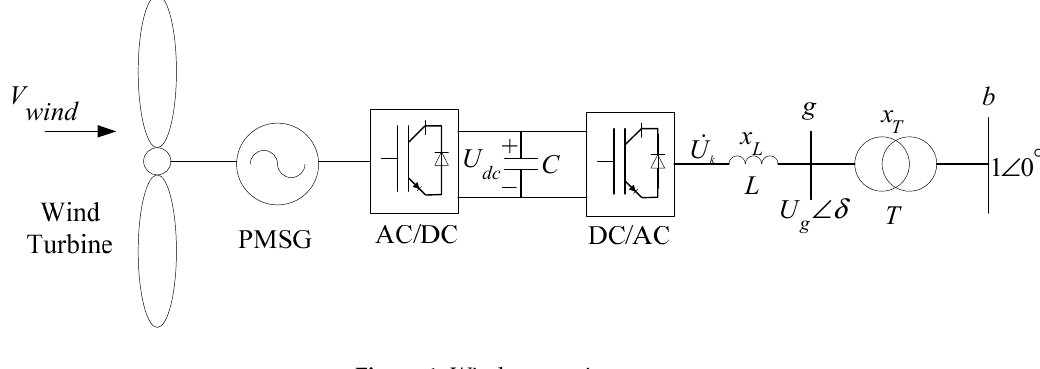
Figure 1. Wind generation system.